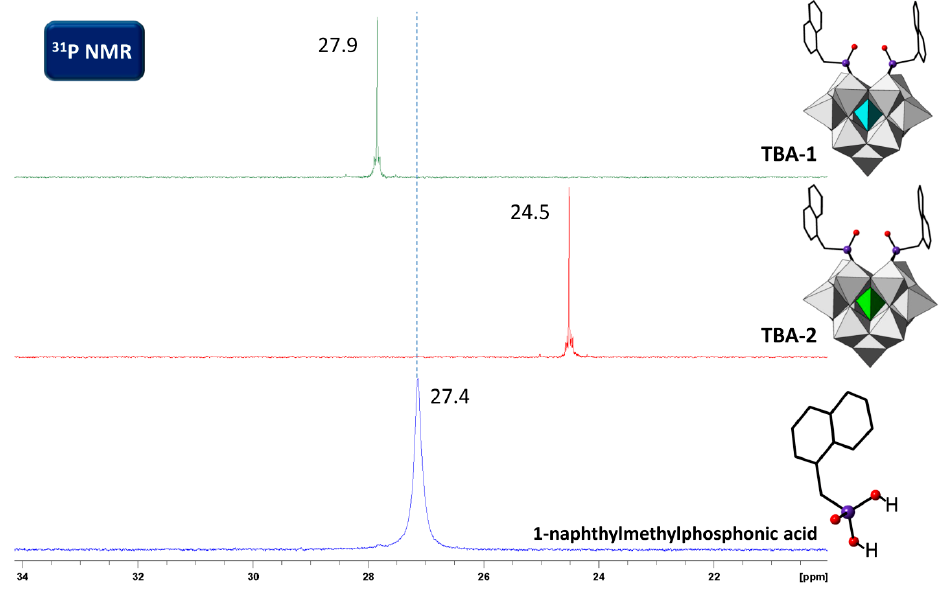
Figure 9. 31 P-NMR spectra of TBA-1 and TBA-2 in acetone- d 6 compared with that of the commercial 1-naphthylmethylphosphonic acid.